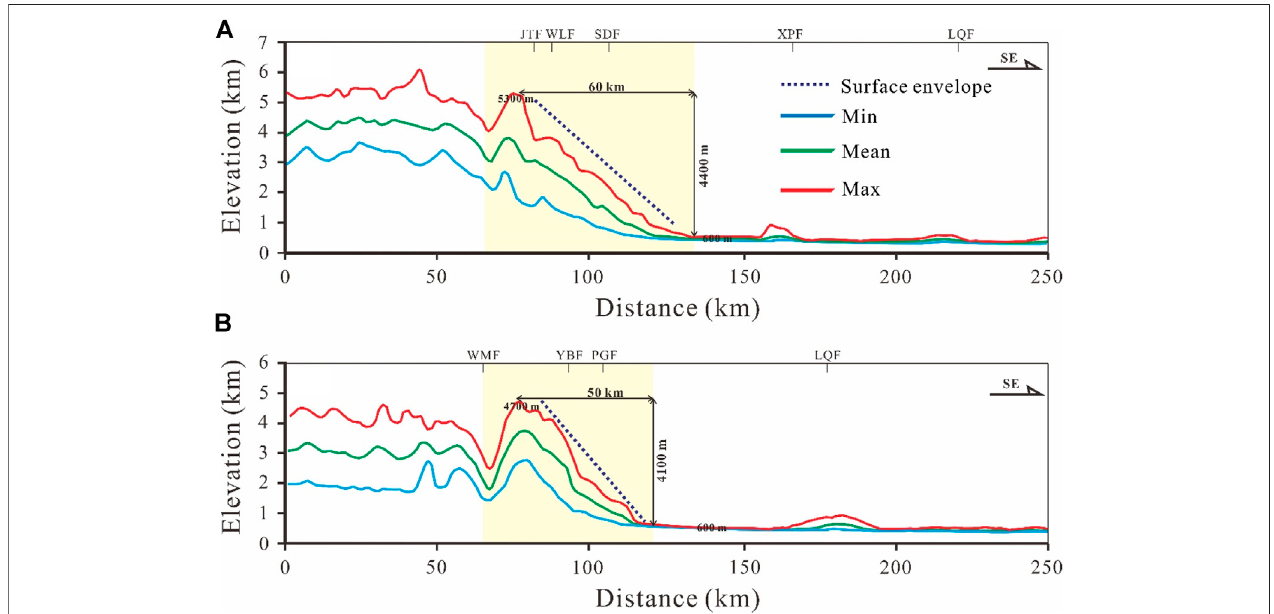
FIGURE 14 | Swath pro fi les of the southern LMS (A) and central LMS (B) in the eastern Tibetan Plateau (from Sun et al., 2016). The LMS fold-thrust belt is highlighted by yellow background color.